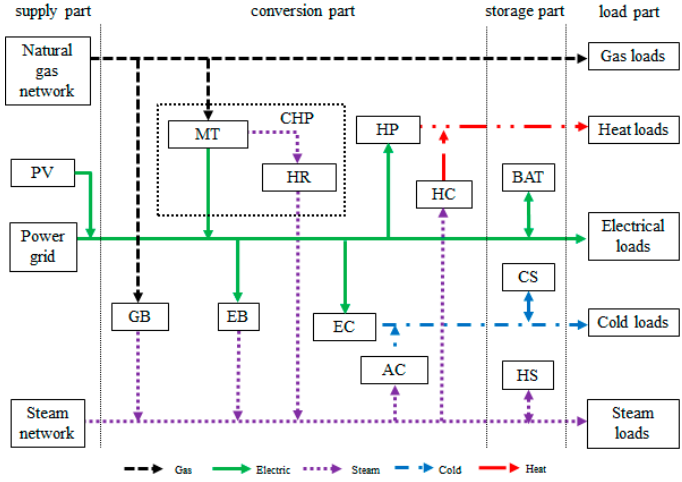
Figure 1. Structure and energy flow of industrial park integrated energy system (IPIES).